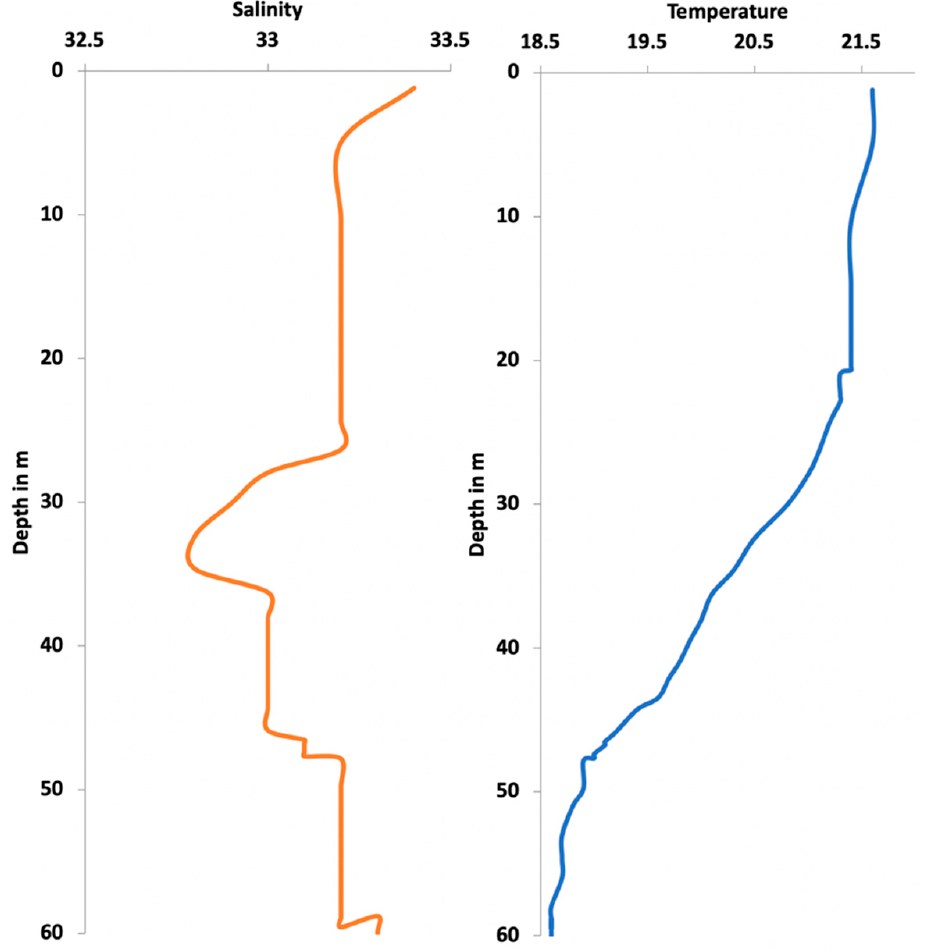
Figure 4. Sample of a depth and temperature profile derived from a CTD unit attached to the suction cup tag. The profile shows the thermocline at 25 m depth followed by a decrease in salinity.